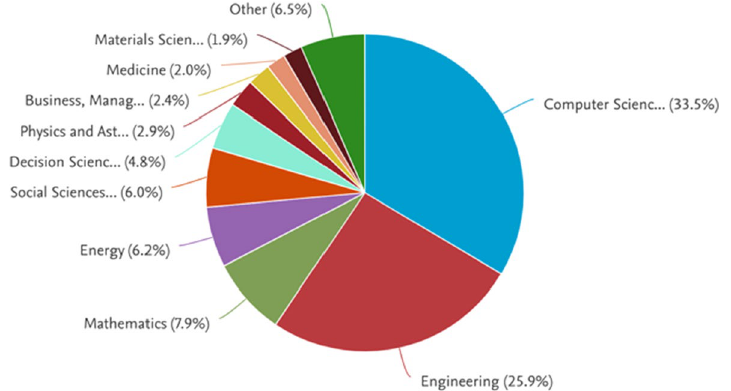
Fig. 2 The proportion of publication on cybersecurity by area since